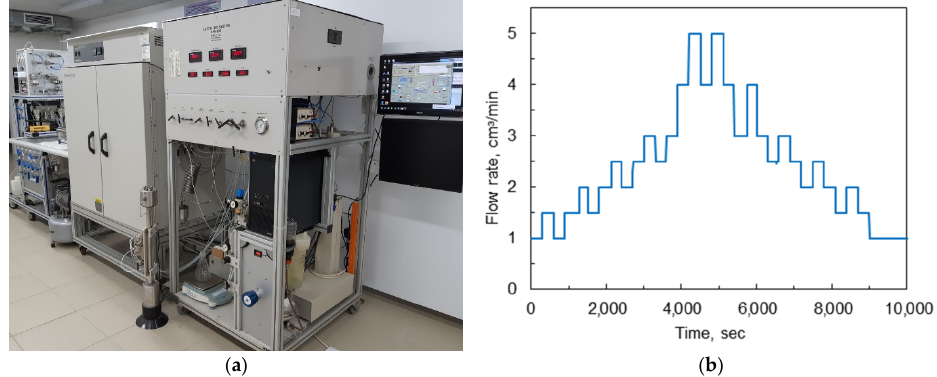
Figure 6. AFS 300 coreflood apparatus ( a ) and coreflooding test program ( b ). Coreflooding was carried out parallel to the rock layers. The fluid was injected with a cyclic flow rate at a constant confining pressure in order to bring the test conditions closer to real ones, when the flow rate can change periodically. The injection program is shown in Figure 6b. The injection rate varied stepwise from 1 to 5 cm 3 /min; each injection rate lasted for about 5 min. The whole injection cycle lasted about 2–3 h depending on sample permeability.